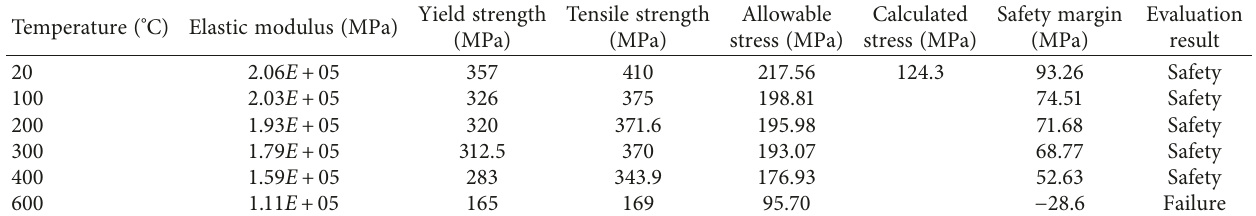
Table 5: Structural stress and safety evaluation results of main beam at different